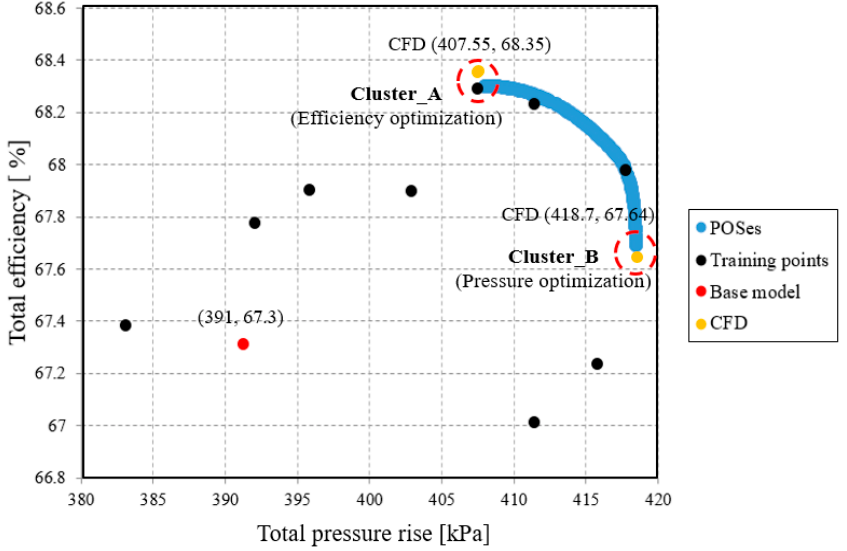
Figure 7. Pareto-optimal frontiers within the design space.